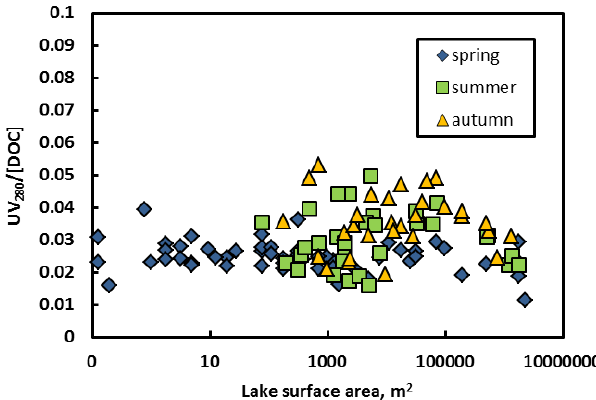
Figure 2. DOC concentration in thermokarst lakes of various sizes during four observation seasons.